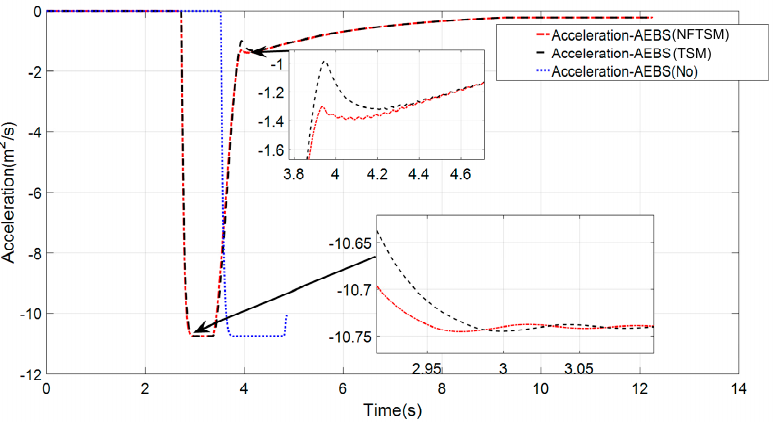
Figure 14. Comparison of vehicle acceleration.